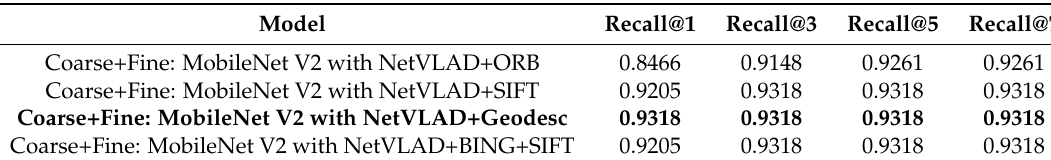
Table 9. Localization results of coarse-to-fine system when simplifying models on the Chengyuan dataset across morning and afternoon—subset 3 as query, subset 1 as database.